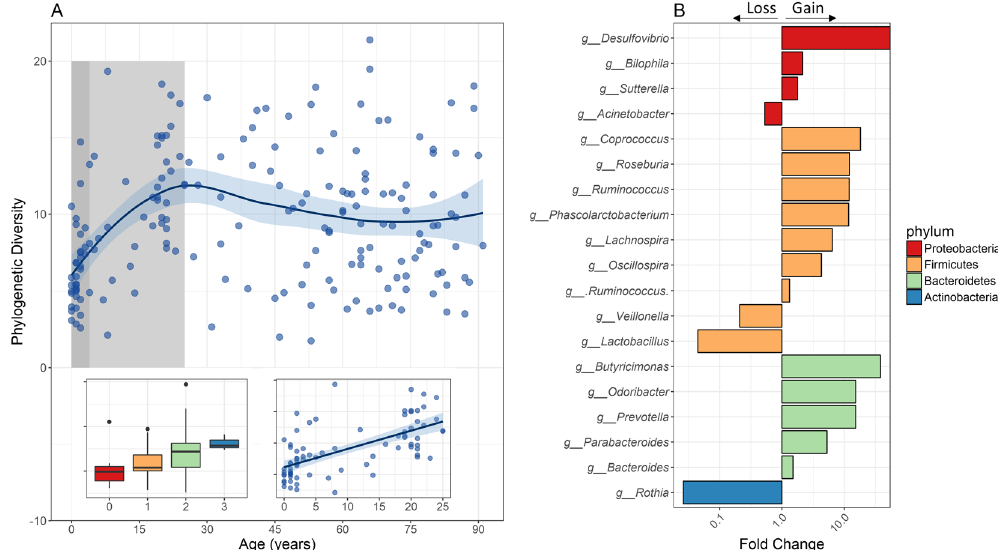
Figure 1. Age-related effect on gut Microbial diversity and composition of hospitalized patients’ with suspected infectious diarrhea. ( A ) Phylogenetic diversity (a measure of within sample diversity, or α -diversity) of hospitalized Israeli patients’ fecal microbiome OTU relative abundance plotted against age, for all sample across all ages, with a local polynomial regression fitting calculated by weighted least squares method, and a 0.95 confidence interval using a t-based approximation. Dark-shaded box represents years 0–4. Light-shaded box represents years 4–25. Right inset represent the same calculation during the first 25 years of life, with a linear regression fitting. Left inset, a boxplot for the first 4 years of life (0– < 4). ( B ) Fold change in taxonomic abundance between adults (18–70 years) and infants and toddlers (0– < 4 years). A fold change greater than one represents a gain in adults, and lower than one a gain in children and toddlers. Results are shown for taxa with a significant change over age, as inferred by a MaAsLin analysis (see methods), at the genus (g) level, for taxa from the phylum Proteobacteria, Firmicutes, Bacteroidetes, and